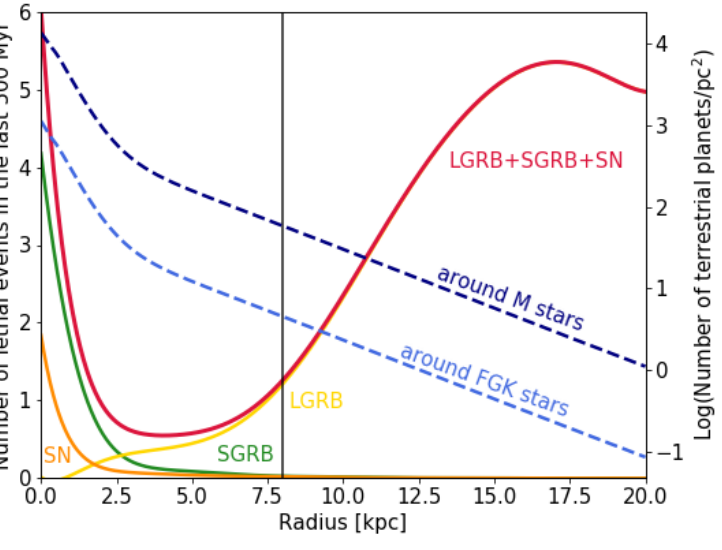
Figure 8. Number of lethal astrophysical transient events (solid red line) in the past 500 Myrs as a function of distance from the galactic center. The individual contributions of SGRBs (solid green line), LGRBs (solid yellow line), and SNe (solid orange line) are shown. The surface number densities of TPs around M stars (dashed dark blue line) and around FGK stars (dashed light blue line) are reported (right vertical axis). The vertical solid black line at 8 kpc marks the position of the solar system at which the total number of lethal events (predominantly LGRBs) is „